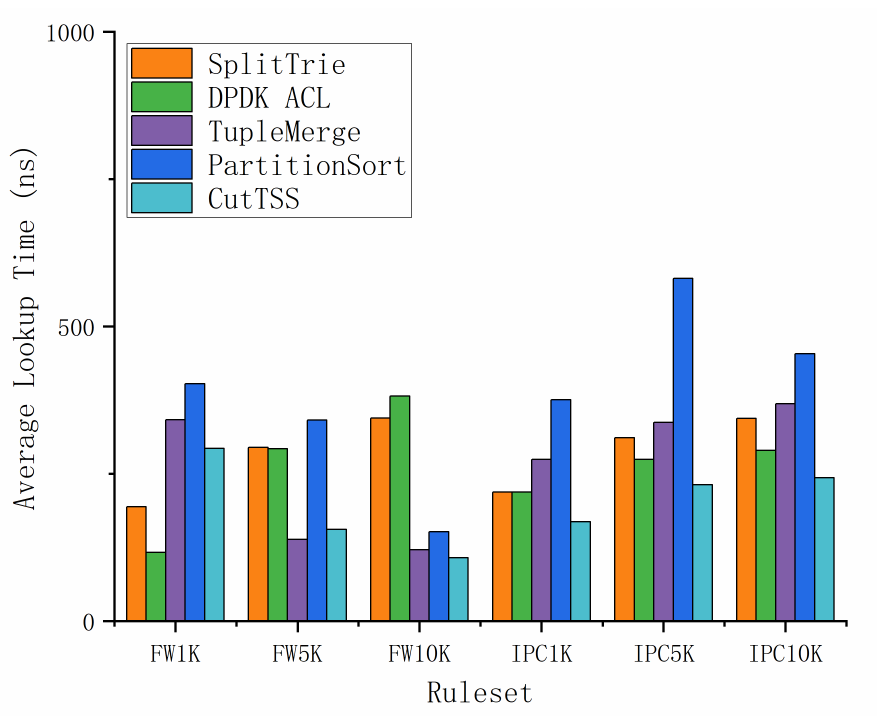
Figure 10. The lookup time cost comparison with